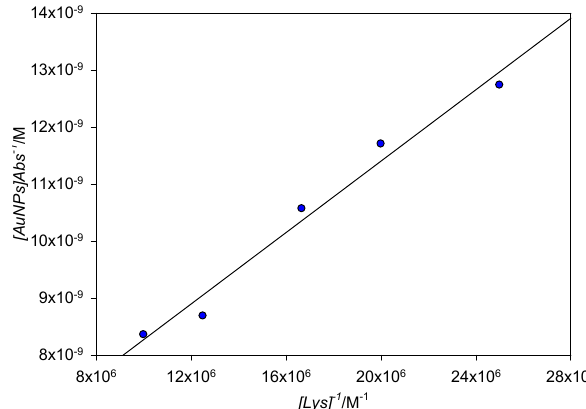
Figure 12. Benesi–Hildebrand plot for the absorbance at 561 nm for [Lys] = 4 × 10 − 8 M–1 × 10 − 7 M.